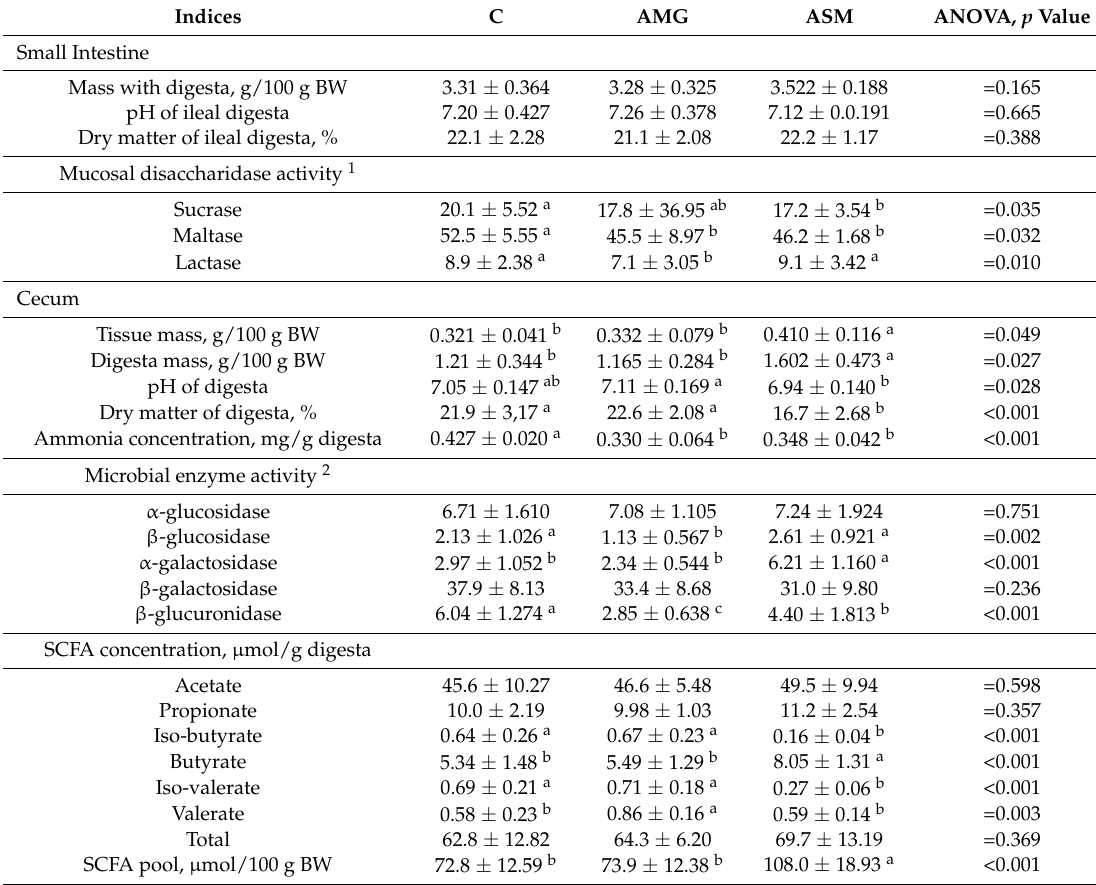
Table 3. Physiological markers of small intestine and cecum in